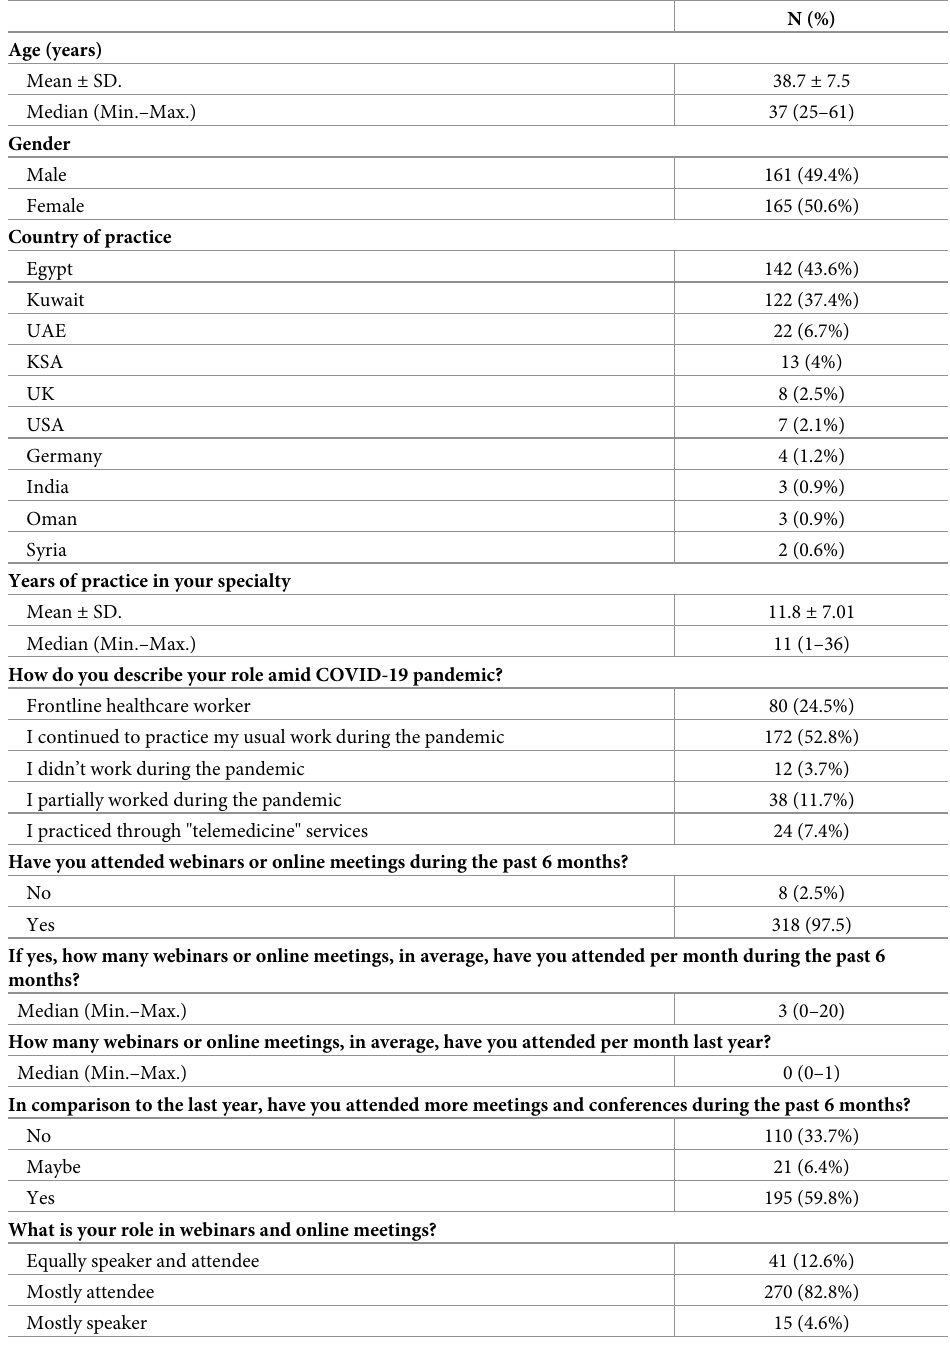
Table 1. Distribution of the survey respondents according to different parameters (n =